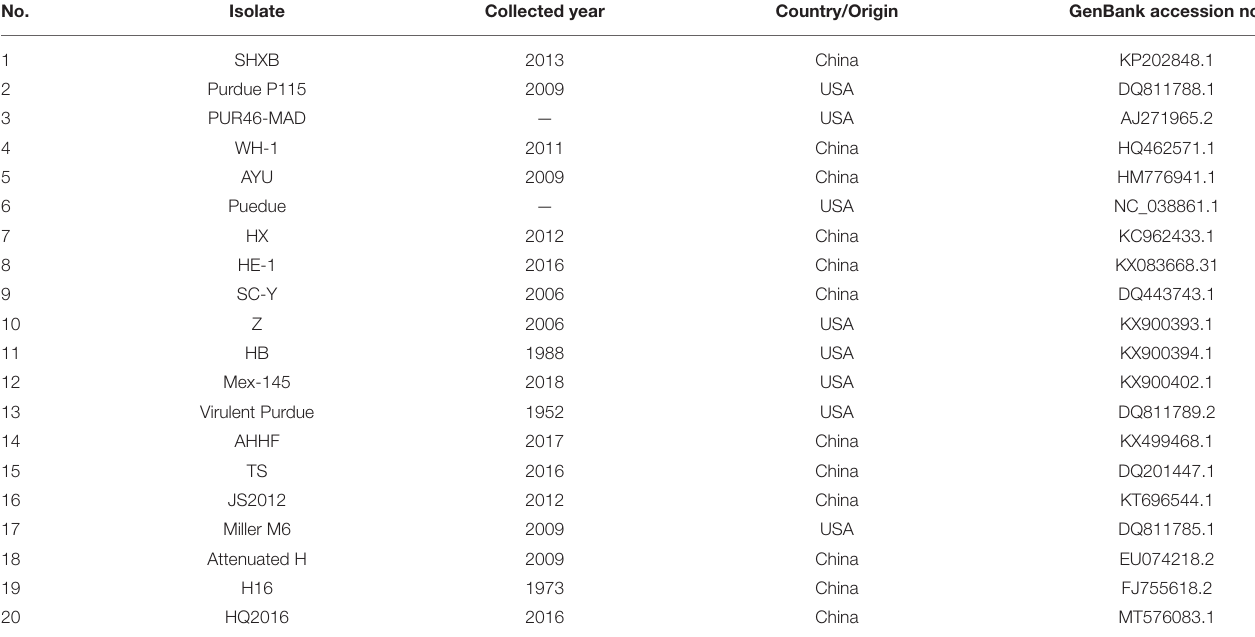
TABLE 1 | Information of the reference TGEV sequences used in this study in the database. No. Isolate Collected year